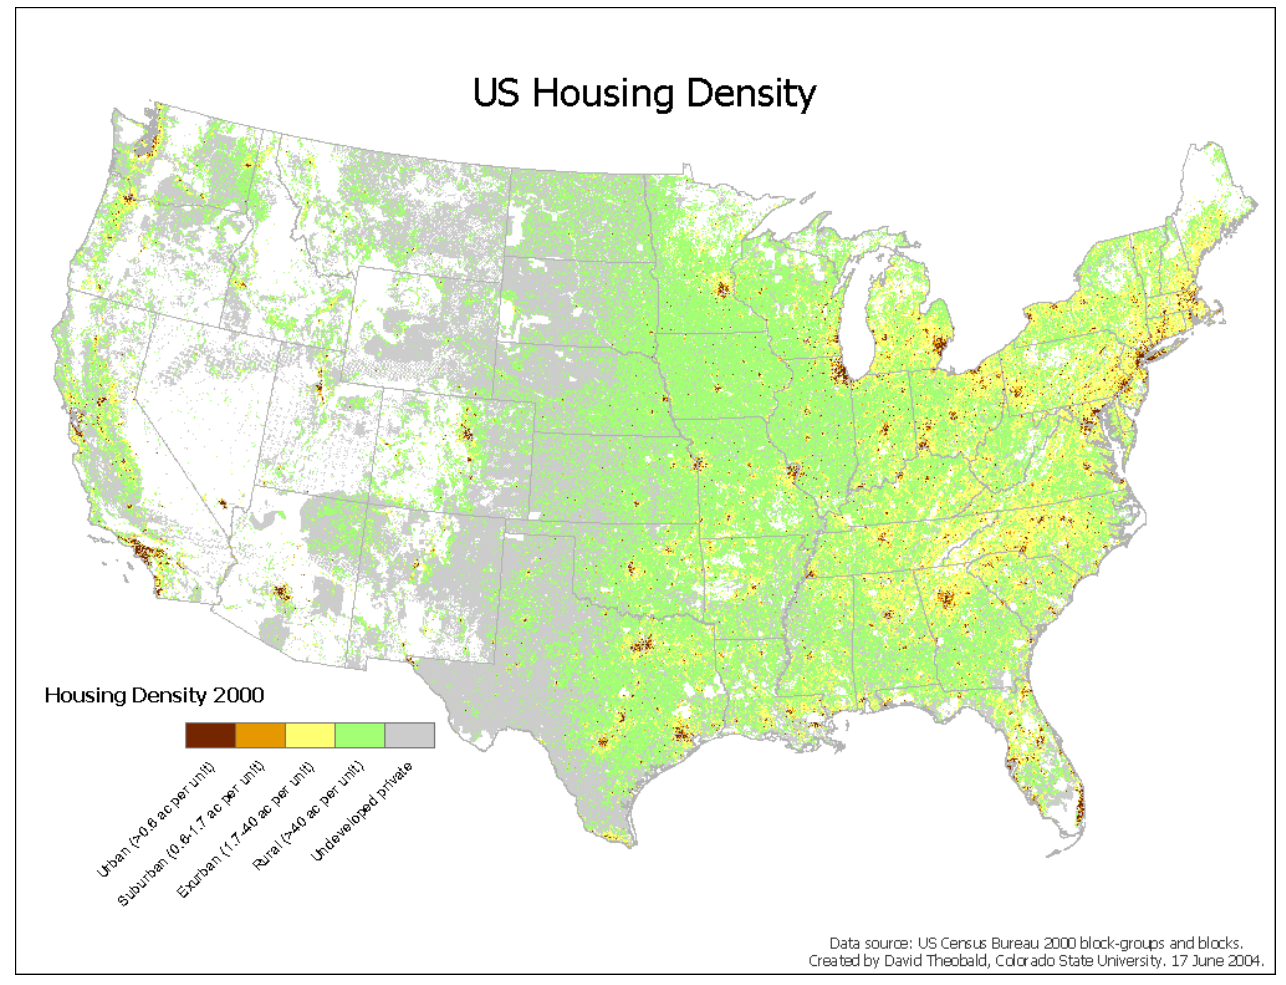
Fig. 6. A low-resolution map showing housing density classes for